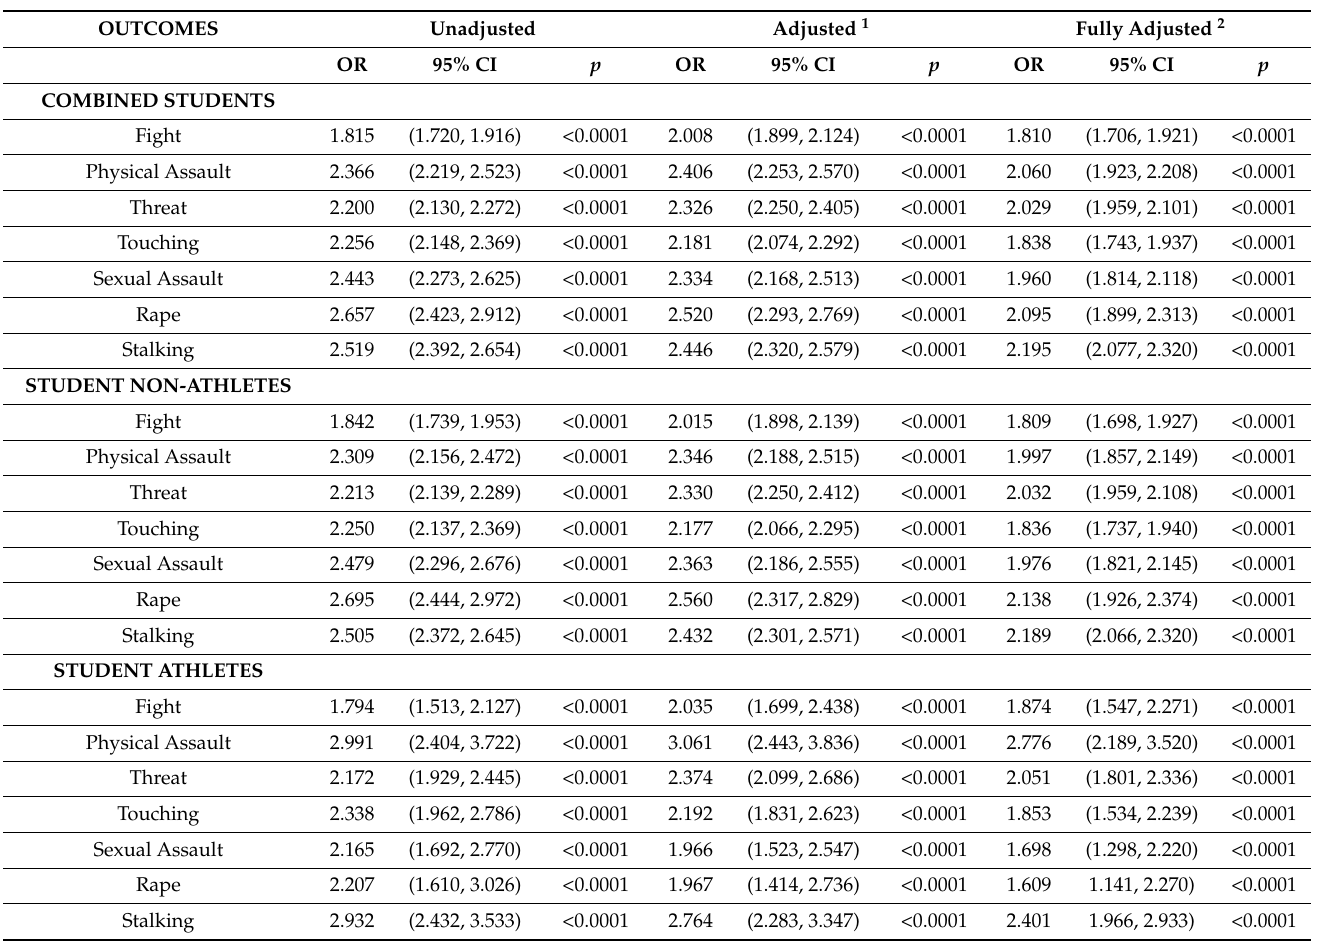
Table 2. Verbal, physical and sexual assaults: their association with sleep difficulties and differences between students and student athletes.